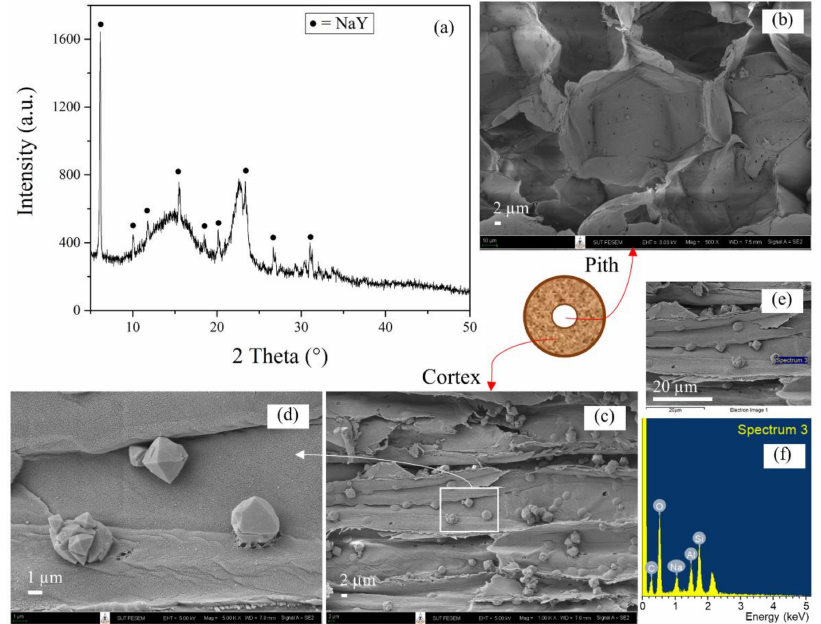
Figure 5. ( a ) XRD patterns, SEM images of Lead tree wood-zeolite composites of refluxed wood (R) ( b ) at pith, ( c , d ) at cortex, and ( e , f ) EDS points analysis spectrum.